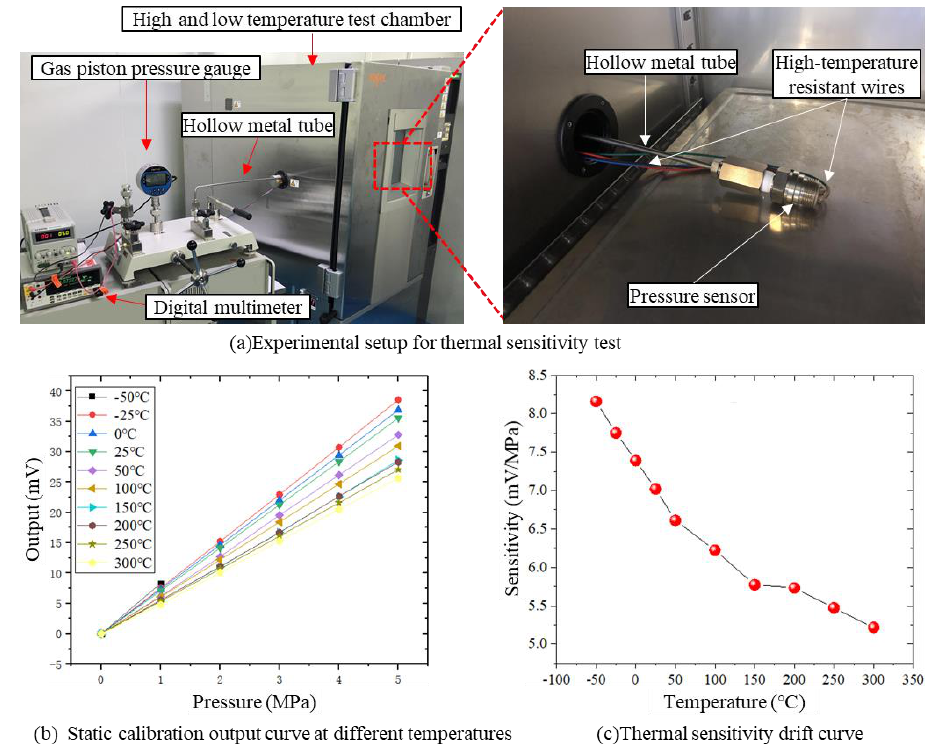
Figure 13. Experimental setup and results of thermal sensitivity drift test.